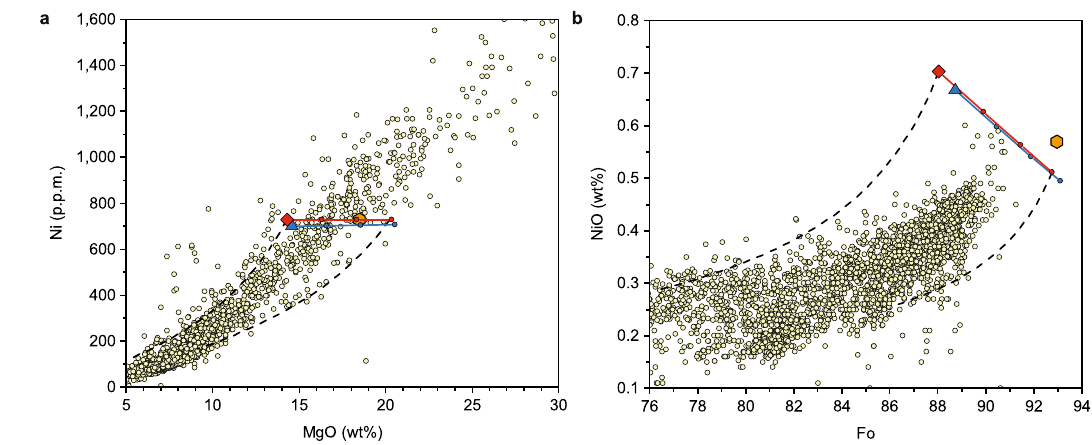
Fig. 2 | Nickel contents of the modeled Hawaiian parental melts and olivines. a Modeled Ni contents of the peridotite-derived primary melt and melts derived from it through clinopyroxene and garnet precipitation and subsequent ortho- pyroxene assimilation (see the caption ofFig. 1). b Modeled Nicontentsof olivines